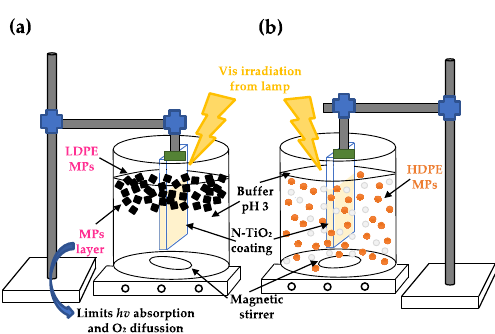
Figure 8. ( a ) Formation of LDPE microplastic (MP) layer in liquid–gas interface during photocatalytic experiments; and ( b ) dispersion of HDPE MPs in reaction medium.